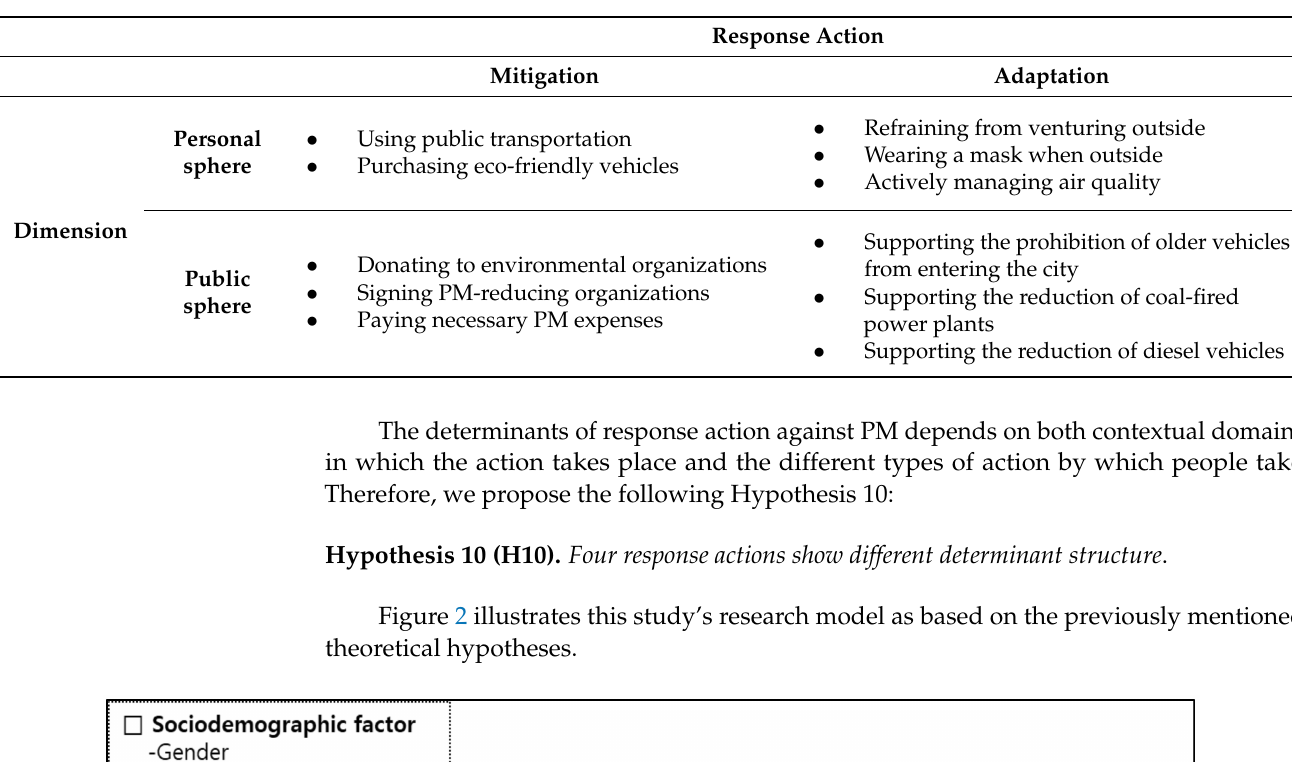
Table 1. Typology of response actions against particulate matter (PM).